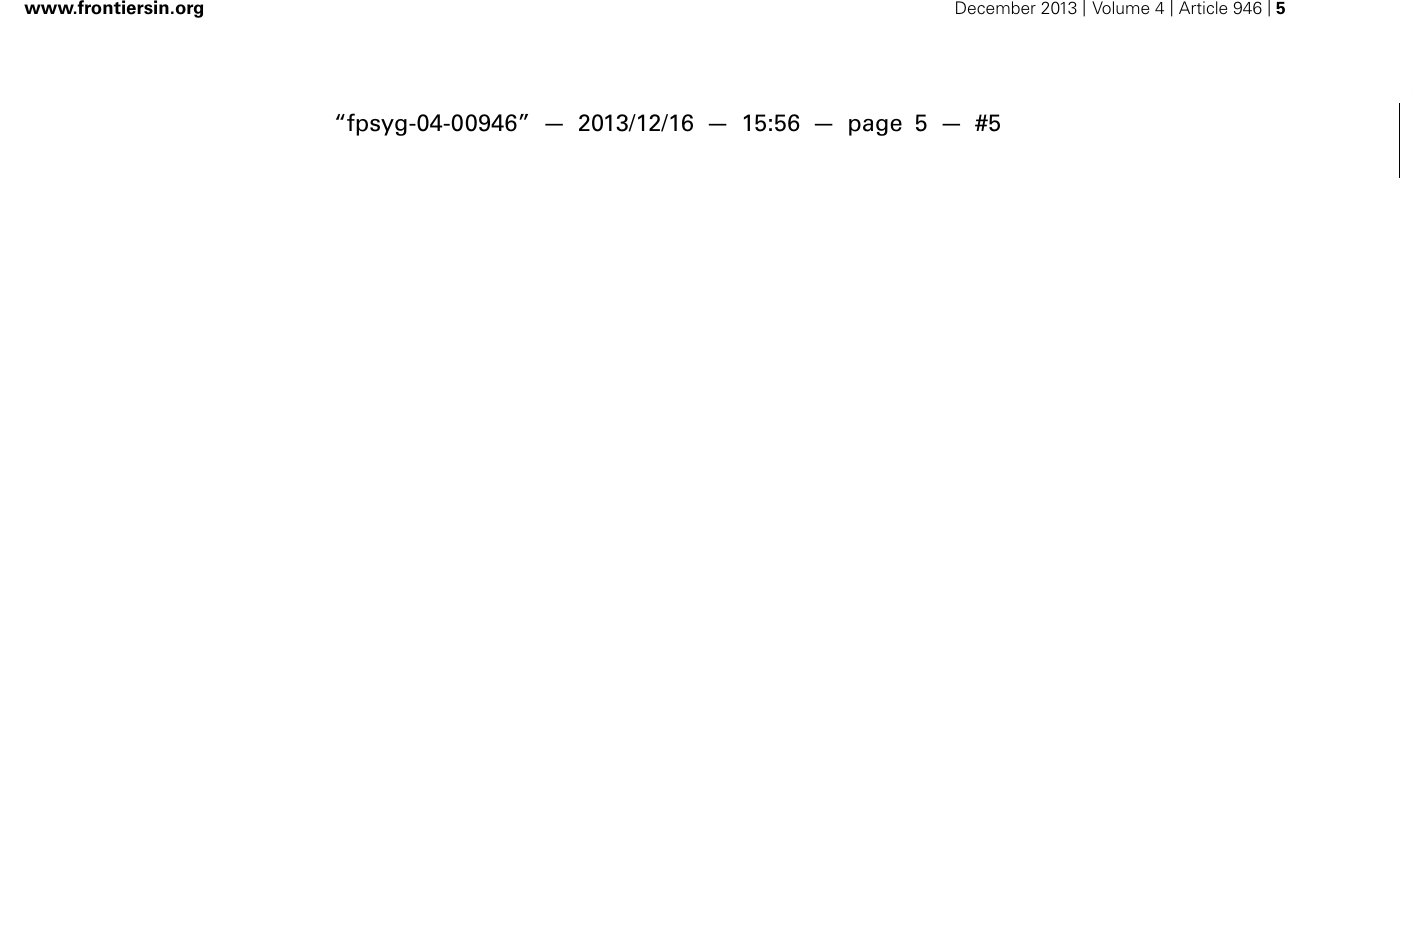
to publication of their photograph. (B) Visual stimulus projected in stereo in the HMD for the body condition. (C) Visual stimulus projected in stereo in the HMD for the object